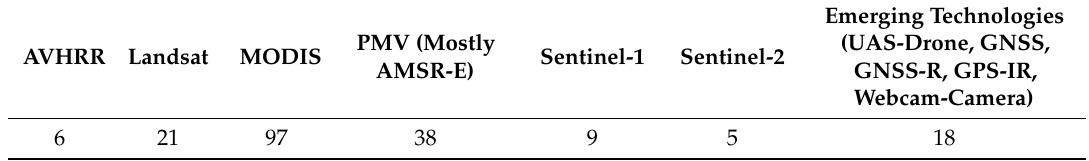
Table 1. Number of published papers on remote sensing of snow between 2015–2019 in Web of Science.